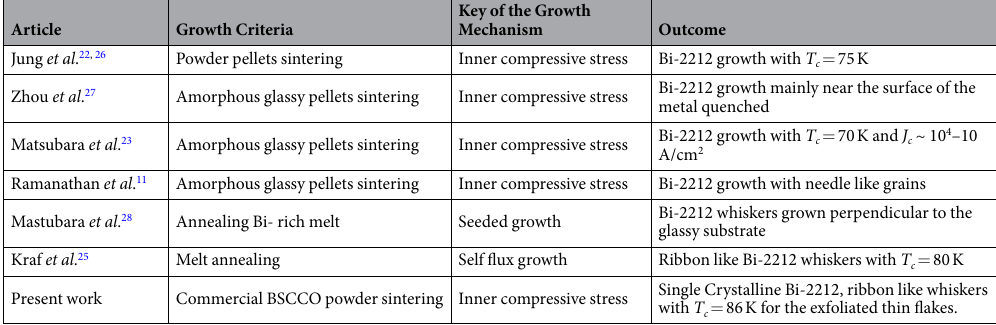
Table 1. Comparison of Bi-2212 growth by various groups on melt quenched process with the present